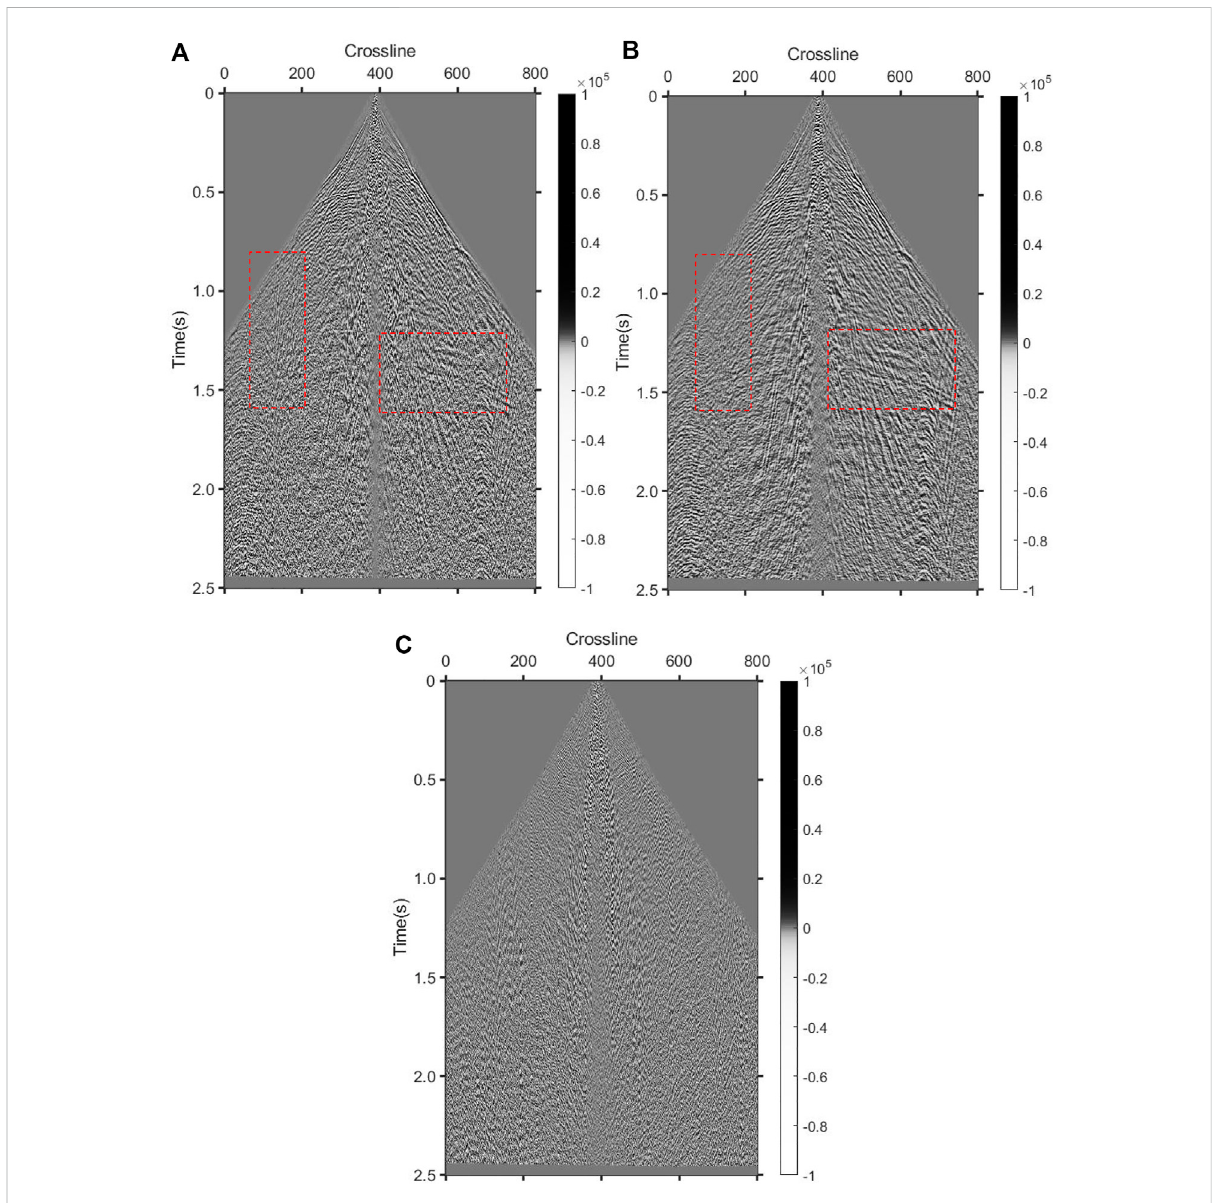
FIGURE 20 Real data denoising. (A) Original data (SNR=1.69 dB PSNR=26.79 dB). (B) Denoised data (SNR=5.93 dB PSNR=31.02 dB). (C) Removed